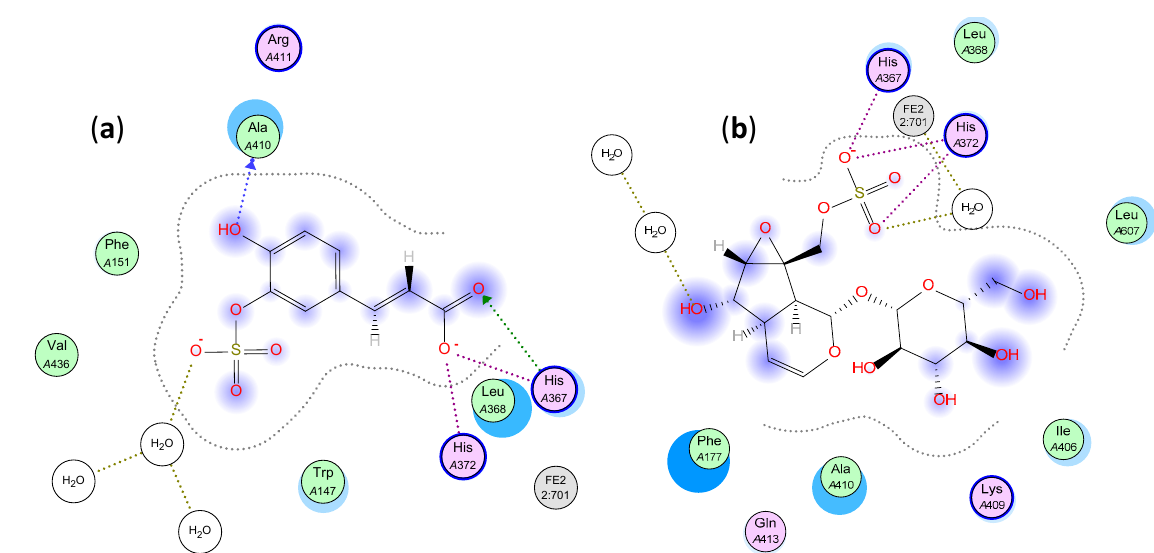
for COX-2 compared to COX-1, which confirms their higher selectivity towards COX-2, Table 4. It is worth mentioning that docking results were shown to be in agreement with the in vitro activities. Figure 5. Two-dimensional interactions of ( a ) caffeic acid sulphate and ( b ) catalpol sulphate with 5-LOX. For COX-2, luteolin glucoside, rosmarinic acid and caffeic acid glucoside showed the